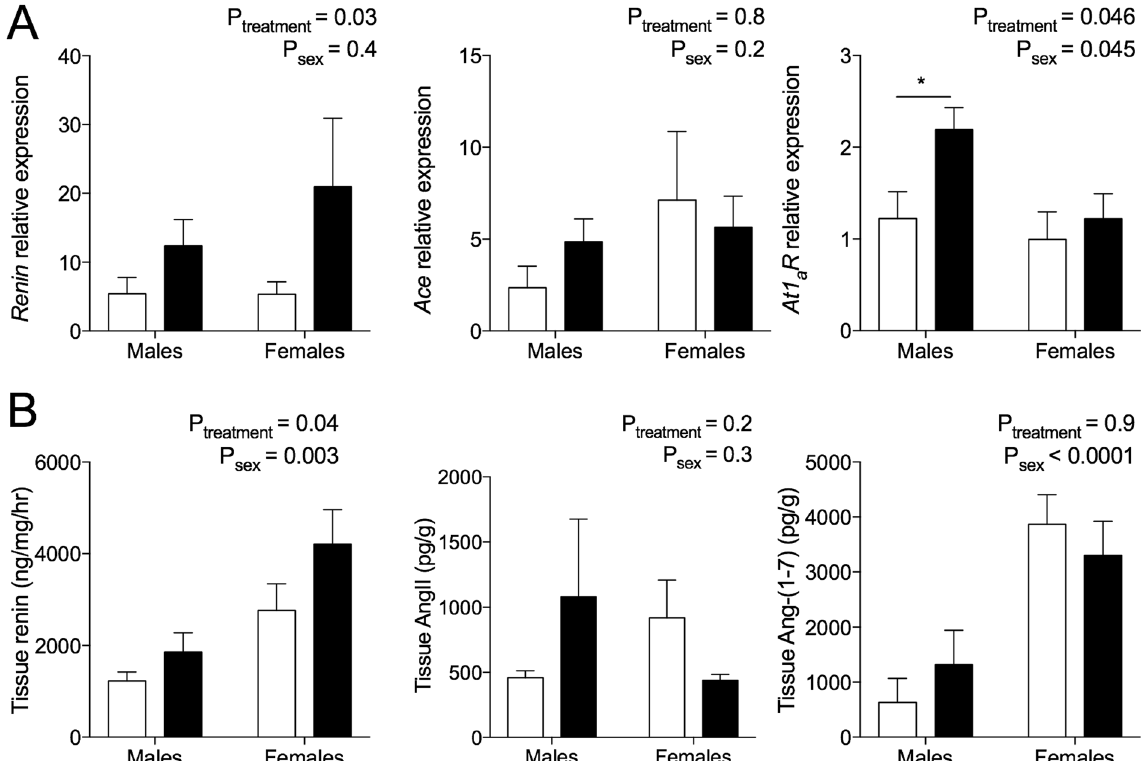
Figure 2. Renal renin-angiotensin system expression at 12 months of age. ( A ) Renin , At 1a R and Ace relative mRNA expression presented relative to the control male, with ß-actin as a housekeeper. Male: 7–11/group; female: N = 5–6/group. ( B ) Renal tissue concentrations of renin, angiotensin II and angiotensin-(1–7). Male: N = 11/group; female: N = 7–9/group. Data analysed via two-way ANOVA. Values are mean ± SEM. * P < 0.05 by Sidak post hoc . Control: open bars; hypoxia: closed